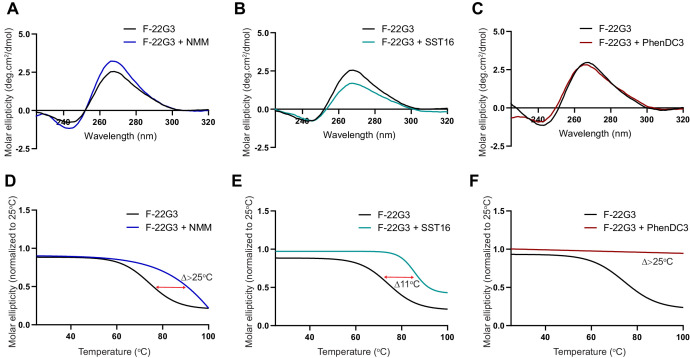
Demonstration of ligand-mediated stabilization of F-22G3.(A – C) CD spectra and (D – F) melting curves measured by CD at 260 nm of 250 nM F-22G3 in the presence or absence of 40 μM NMM, 5 μM SST16 or 1 μM PhenDC3. NMM was incubated with F-22G3 during G4 folding at 20-fold higher concentrations, and the G4-ligand complex diluted for CD measurement.